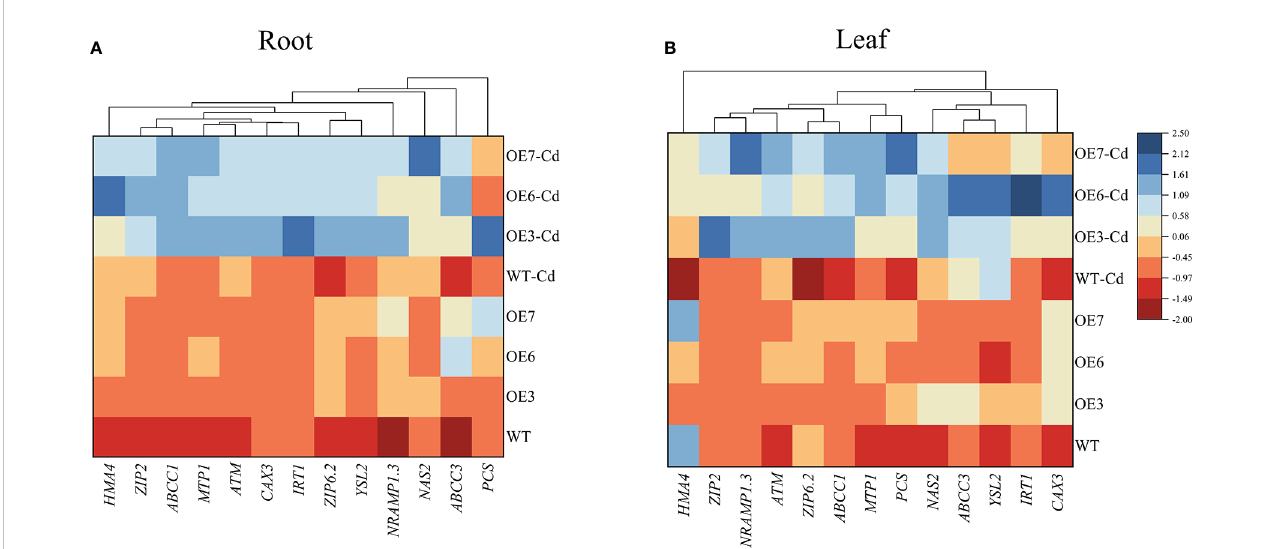
FIGURE 8 Expression levels of key transporter genes in the Cd-treated roots and leaves of WT and transgenic poplar lines treated with 0 or 100 m mol·L − 1 Cd 2+ for 30 days. (A) Root gene expression levels. (B) Leaf gene expression levels. Three biological replicates were analyzed. Red and blue respectively indicate negative and positive Z-scores for the gene expression